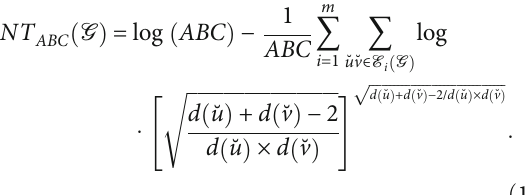
p # ffiffiffiffiffiffiffiffiffiffiffiffiffiffiffiffiffiffiffiffiffiffiffiffiffiffiffiffiffiffiffiffiffi d ˘ u ð Þ + d ˘ v ð Þ − 2/ d ˘ u ð Þ × d ˘ v ð Þ